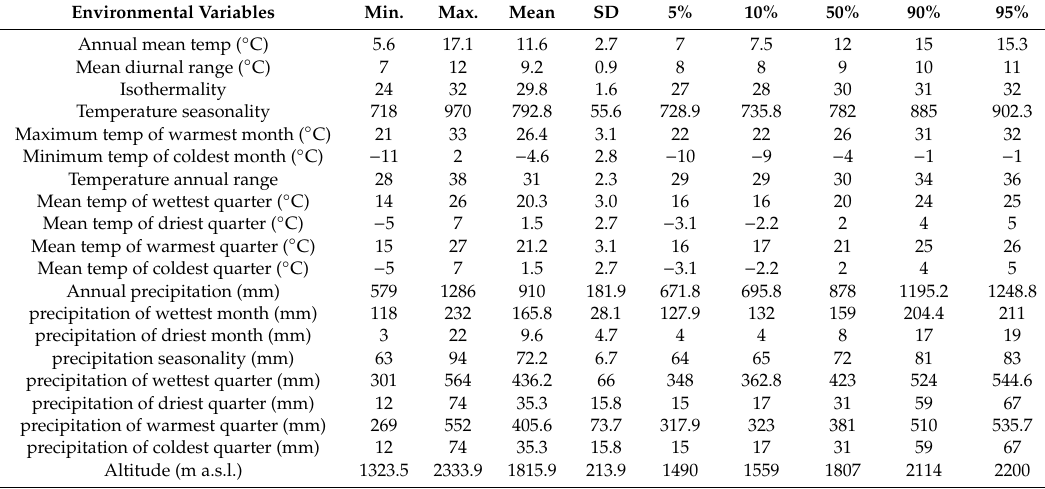
Table 5. Bioclimatic profile of D. armandi for each location (obtained using BIOCLIM). Environmental